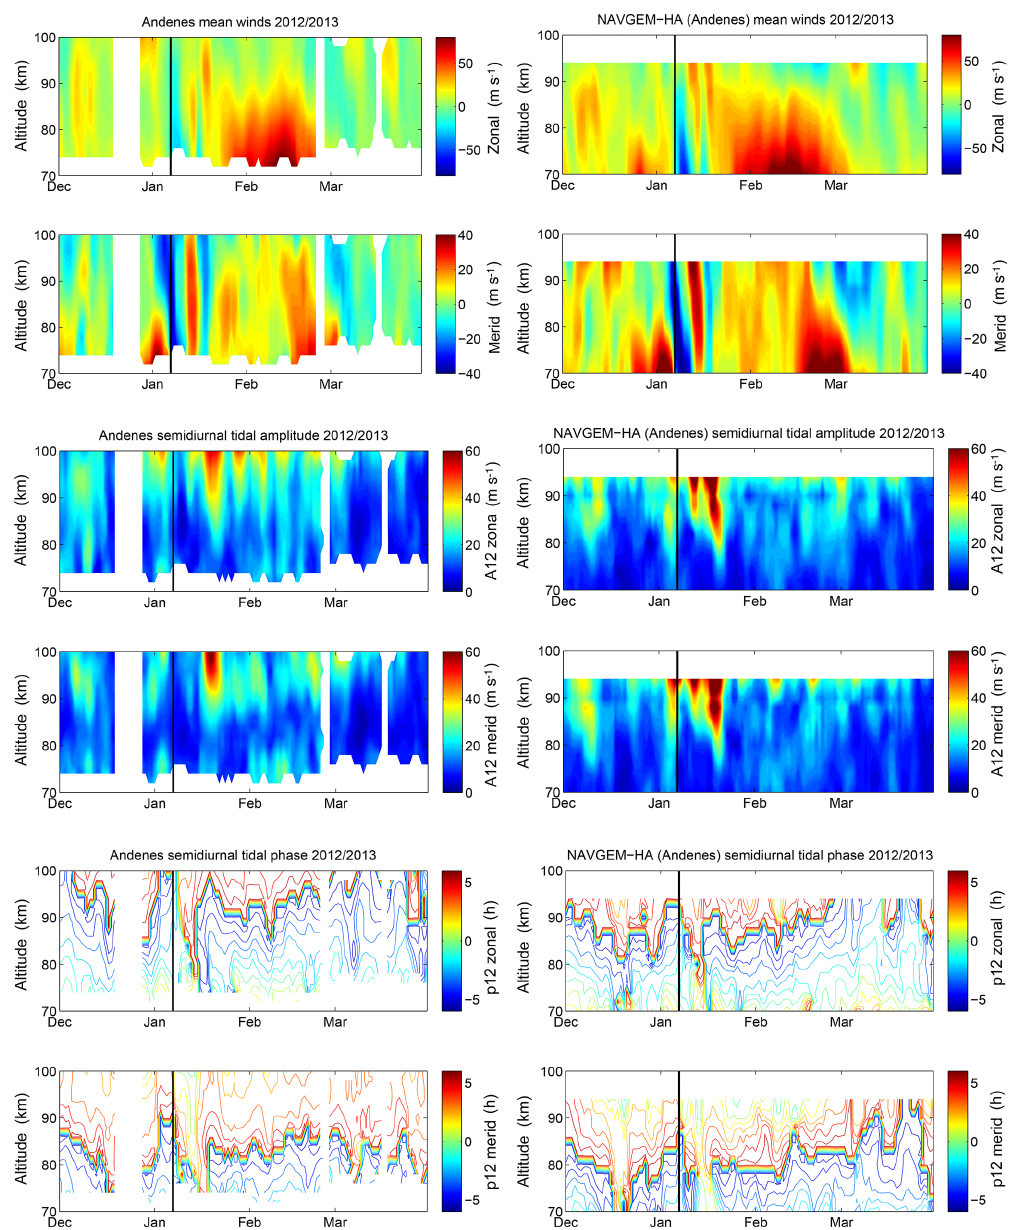
Figure 9. Comparison of meteor radar observations and NAVGEM-HA above Andenes during the winter of 2012/13 for daily mean zonal and meridional winds (two upper panels), semidiurnal tidal zonal and meridional amplitude (middle panels) and semidiurnal tidal phases (two lower panels). The labels A12 and p12 correspond to the semidiurnal amplitude and phase using the local